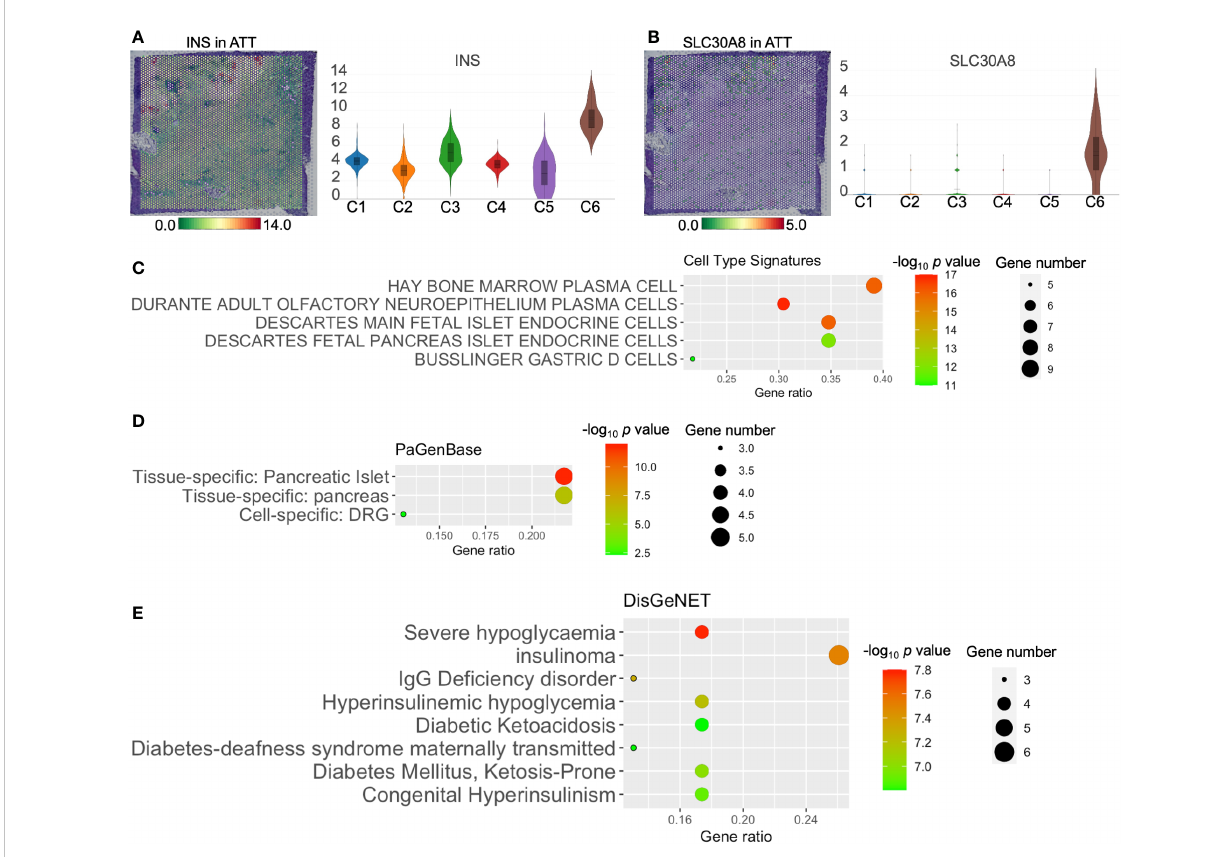
FIGURE 4 The functions of adjacent tumor tissue (ATT)-cluster(C)3, -C5, and -C6. The distribution and level of INS (A) and SLC30A8 (B) in ATT. Cell type signature (C) , PaGenBase (D) , and DisGeNet (E) analysis of ATT-C3 upregulated genes. The bar plots and the vertical coordinate of the violin plots indicates the log 2 FC of the gene expression value of each cluster versus the average gene